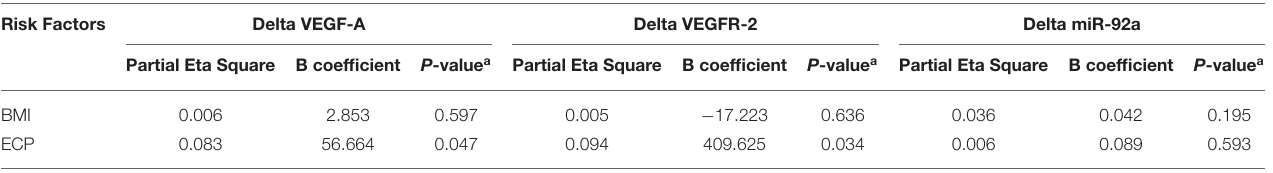
TABLE 4 | Multivariate analysis the effect of ECP on dependent variables.